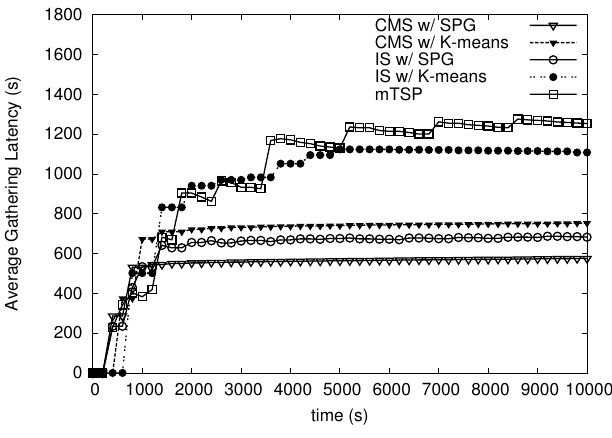
Figure 12. Average data-gathering latency over